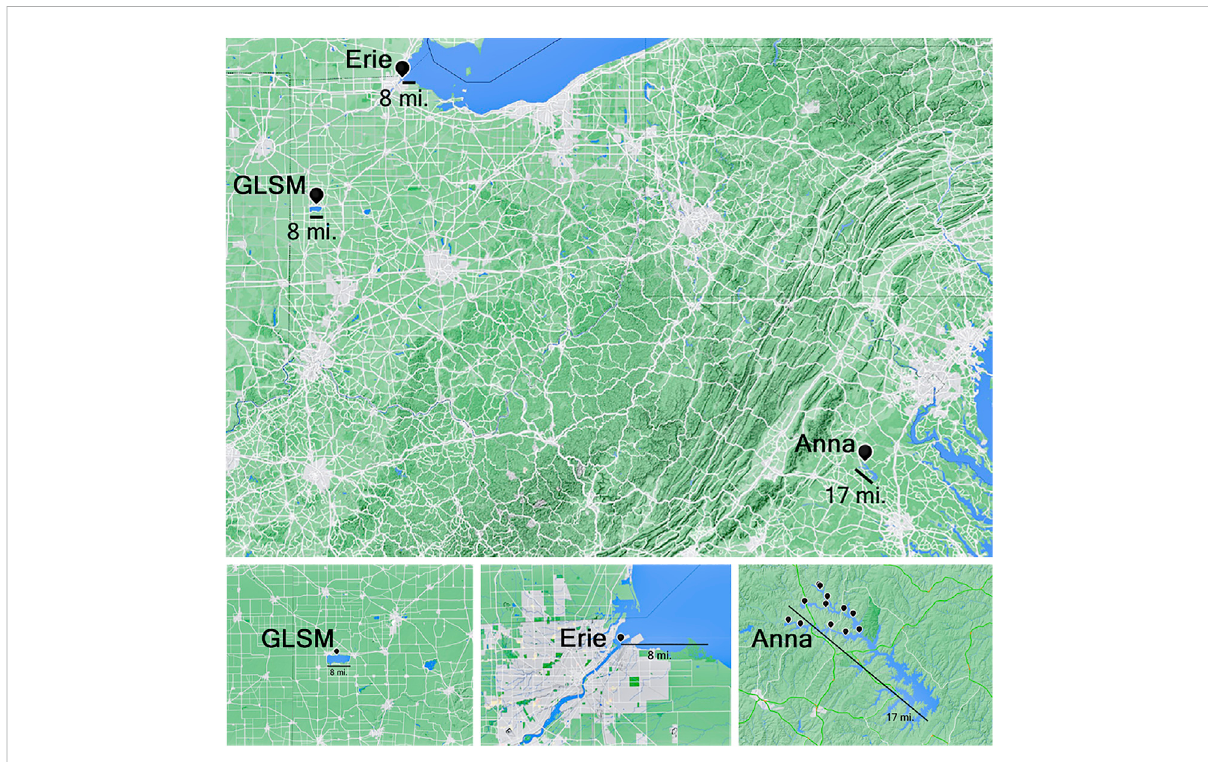
FIGURE 2 Three freshwater lakes with known HABs were sampled in the US in 2019. Locations are marked as follows: Grand Lake Saint Mary ’ s (GLSM), Celina, OH (40.544873, − 84.510843), Lake Erie at Maumee Bay, OH (41.702472, − 83.463598), and Lake Anna, Mineral, VA (multiple sampling locations, with 38.10642, − 77.84076 designating the location near the “ splits ” at the State Park). GLSM, was sampled on August 5 – 6, Lake Erie was sampled on August 8, and Lake Anna was sampled on August 23 and September